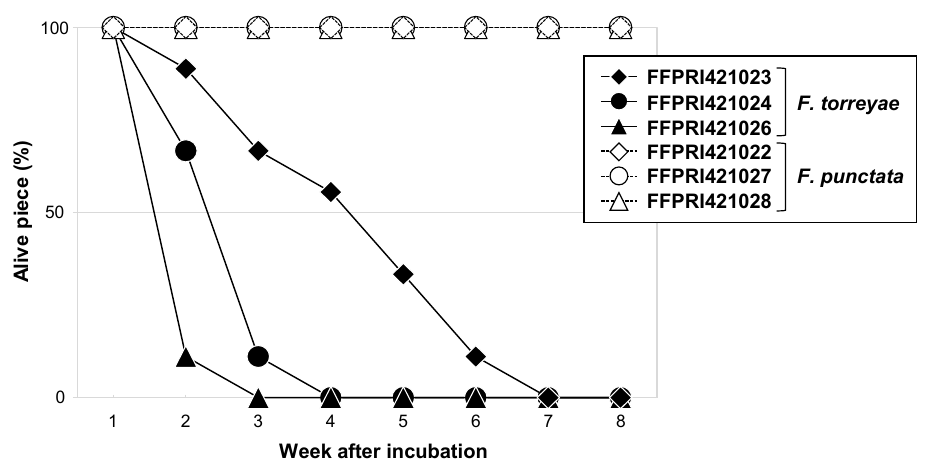
Figure 6. Survival of Fomitiporia torreyae and Fomitiporia punctata isolates at − 5 °C during 8 weeks of